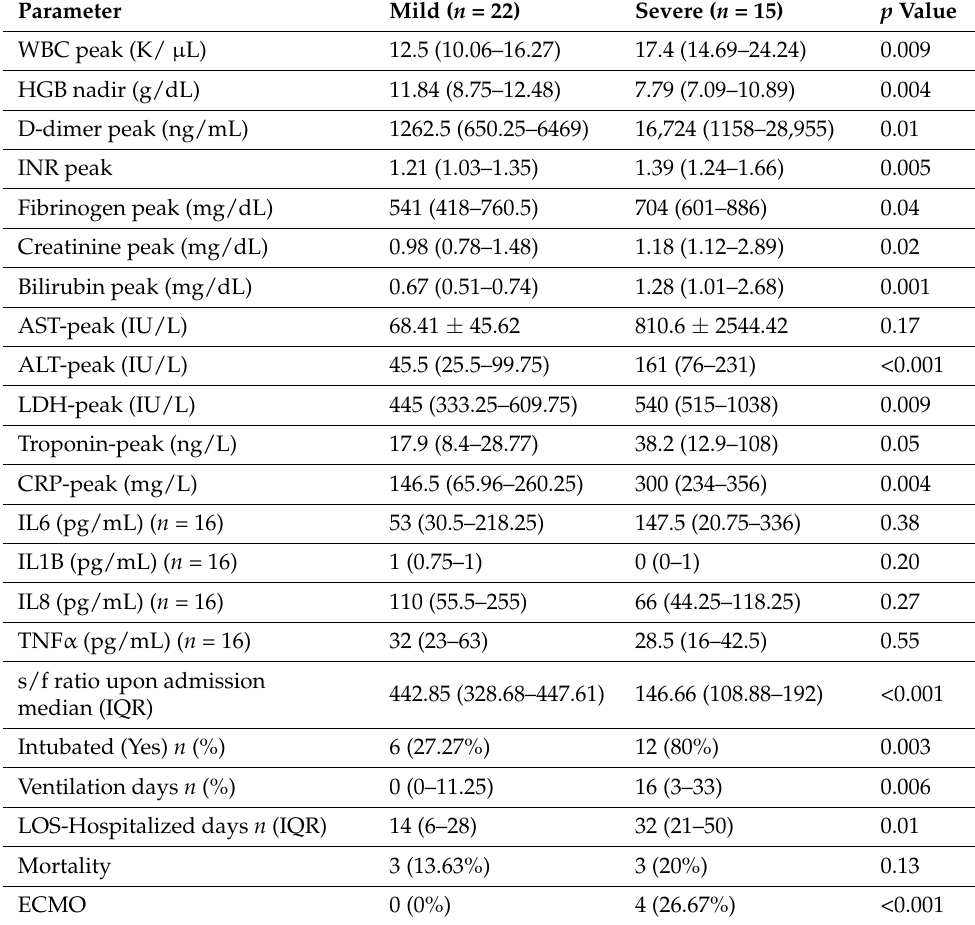
Table 2. Clinical and laboratory parameters and outcome of patients with COVID-19.